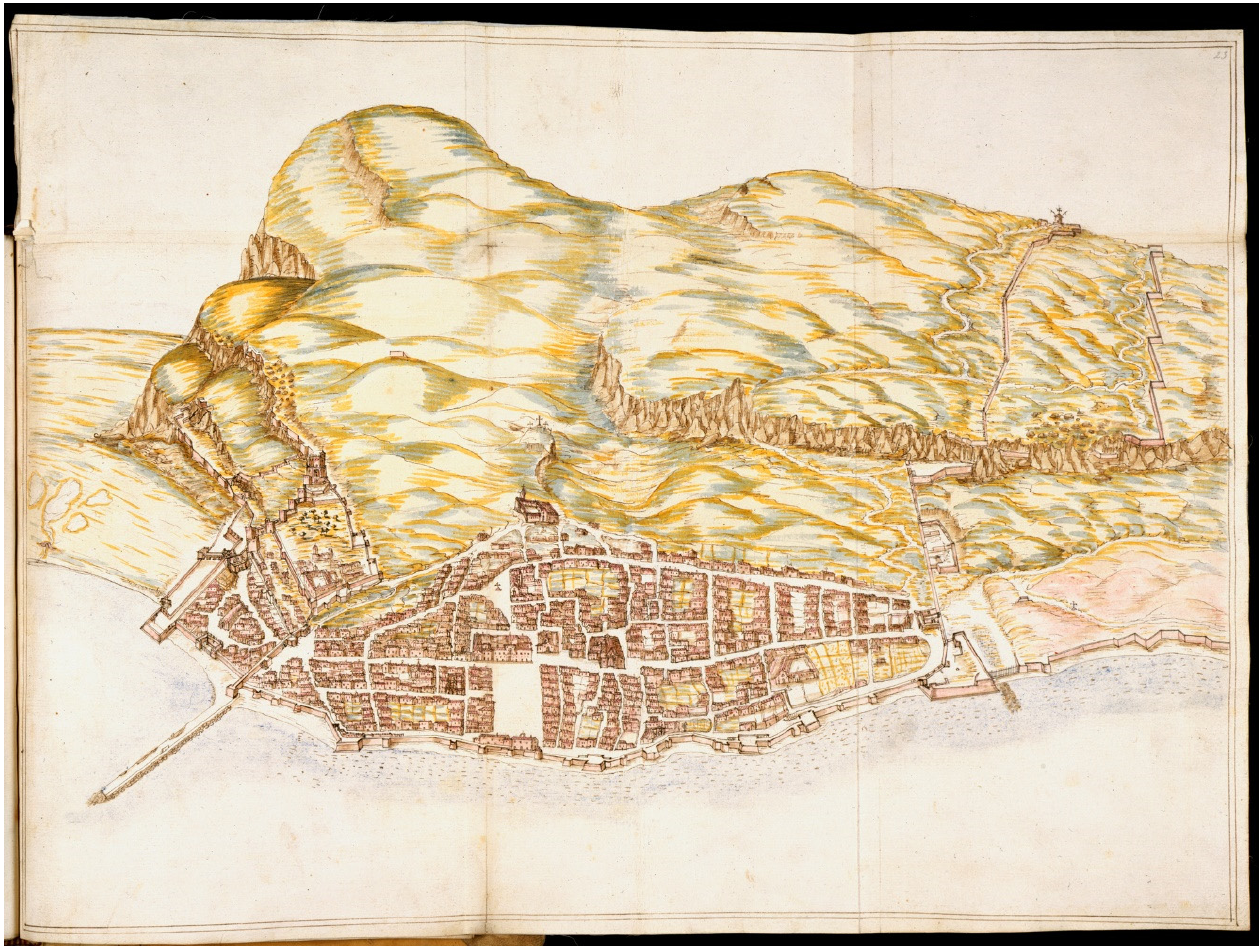
Figure 1. Plan of Gibraltar by Luis Bravo de Acuña (1627). British Library, London, Cartographic Items Additional MS 15152, f. 23r [© British Library, London].